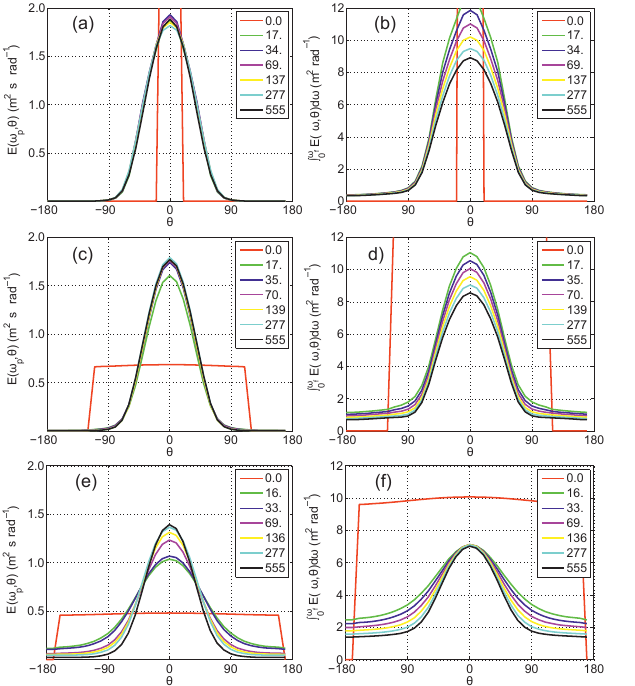
Figure 6. Angular spreading of the swell spectra at different times (in hours; see the legend). Left column – wave spectra at peak fre- quency; right – integral of wave spectra in frequency as a function of direction. (a, b) run sw030 of Table 1 – strong initial anisotropy; (c, d) run sw230 – weak anisotropy; (e, f) “almost anisotropic” run sw330.